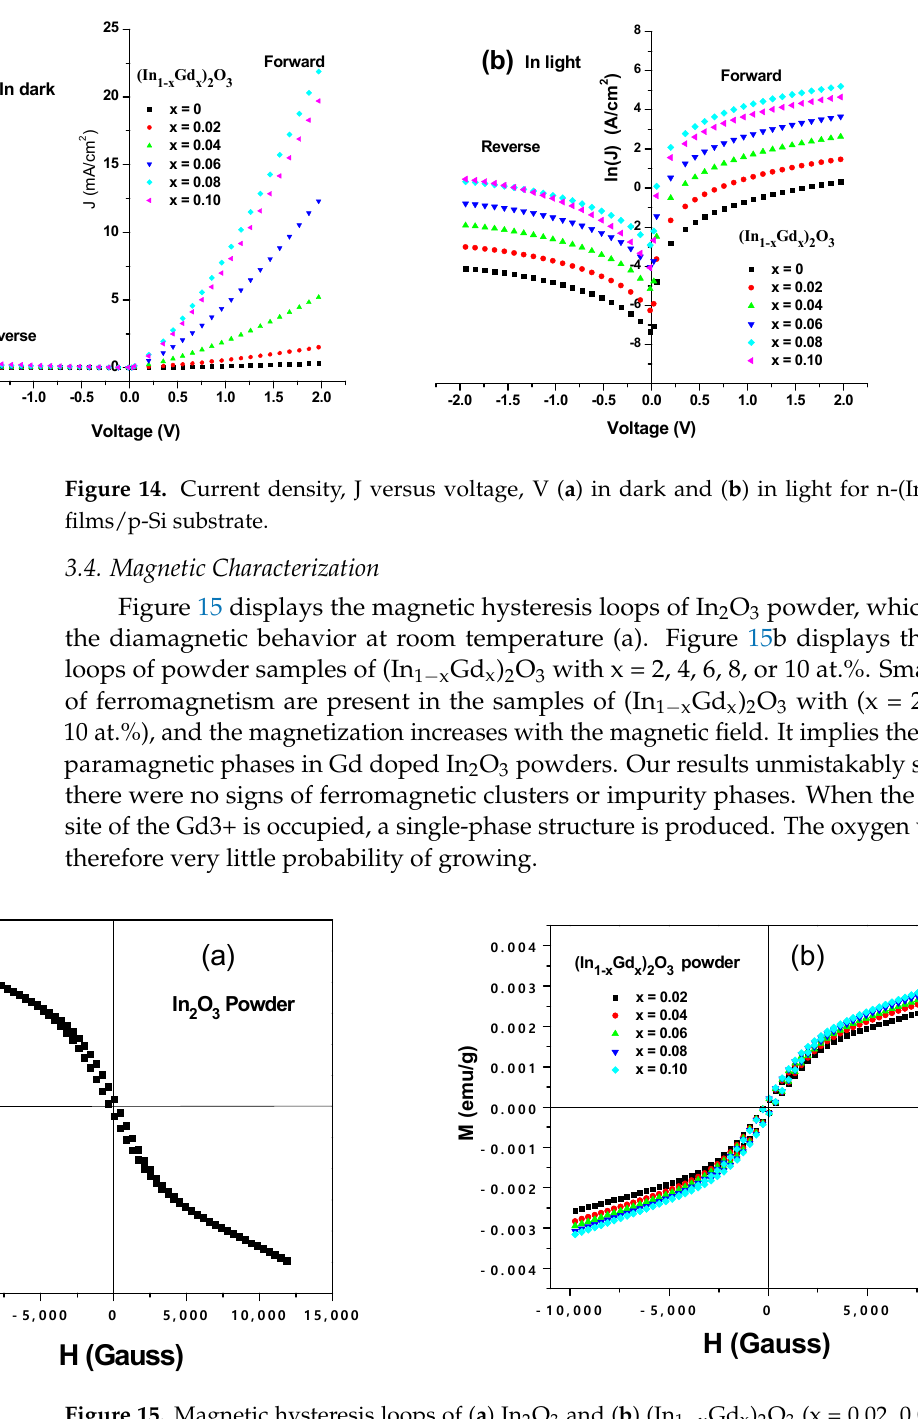
Figure 16. M-H curve for (In 1 − x Gd x ) 2 O 3 thin films. With increasing Gd concentration, (In 1 − x Gd x ) 2 O 3 films become more ferromagnetic at (x = 2, 4, 6, 8, or 10 at.%). The magnetic exchange between Gd +3 and In 3+ surrounding the empty electron trap may be the cause of the enhanced ferromagnetism. Ferromagnetism results from the magnetic exchange of Gd 3+ pairs at the Gd 3+ -F core. As Gd content rises, the saturation magnetization rises as well. 4. Conclusions Using a chemical reaction process, (In 1 − x Gd x ) 2 O 3 powder with x = 0, 2, 4, 6, 8, and 10 at.% was produced. After that, thin layers were evaporated in a high vacuum with an electron gun. The impact of the Gd doping level on the films’ structural, optical, and magnetic characteristics was examined. All of the Gd-doped In 2 O 3 thin films showed the